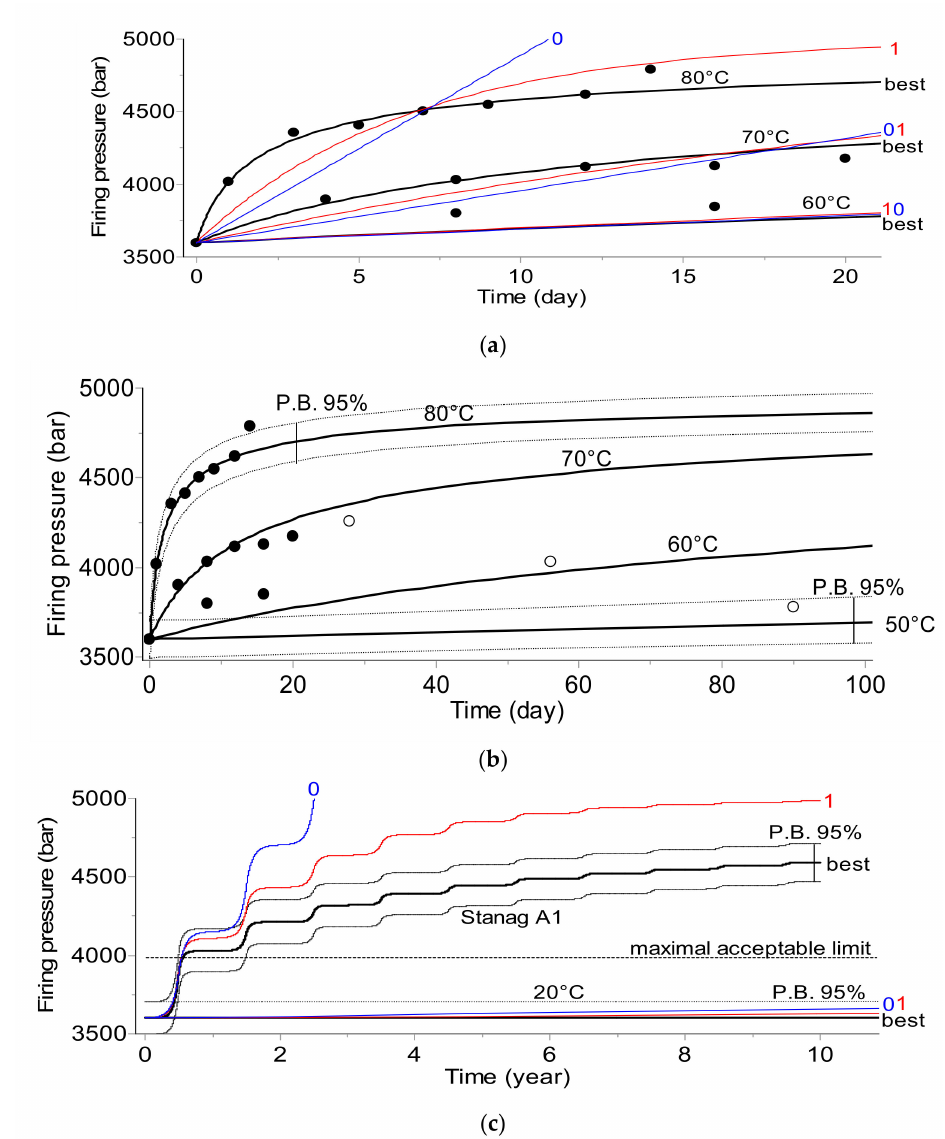
Figure 1. Pressure firing (PF) test. ( a ) Predictions of pressure firing peak values based on 15 experimental points (solid symbols) collected during 20 days in the temperature range of 60–80 ◦ C. Predictions based on the best model are marked in bold, numbers 0 and 1 placed on the solid lines depict the predictions based on the 0th and 1st reaction order, respectively. ( b ) Prediction curves at 50, 60, and 70 ◦ C were verified by the experimental points marked by the open circles. The prediction bands (dotted lines) were determined by the bootstrap method. ( c ) Comparison of the prediction using the best, 0th, and 1st order models at 20 ◦ C over 10 years and for climatic category A1 (diurnal seasonal storage) according to STANAG 2895. The arbitrarily chosen acceptable limit of each measured quantity is marked by a dashed